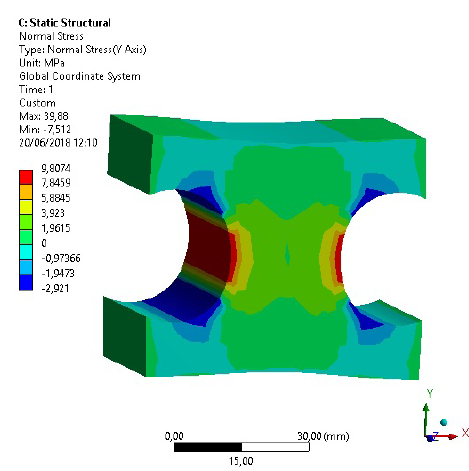
Figure 20. Normal stress distribution for tangential specimen in tension perpendicular to grain tests.